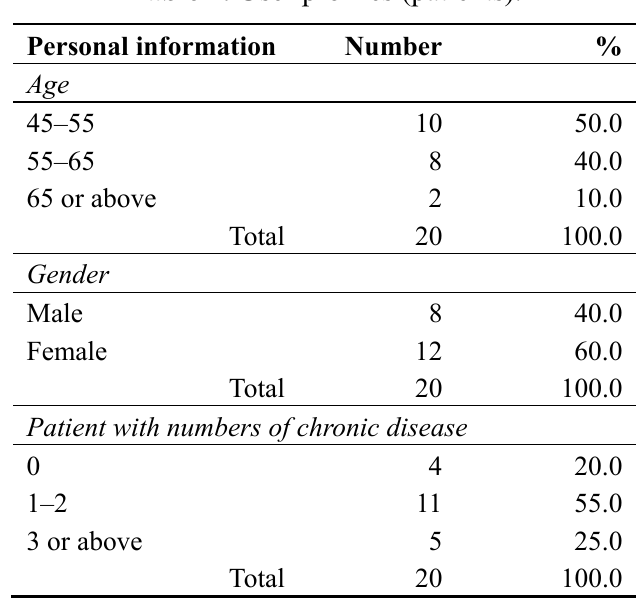
Table 4. User profiles (patients).